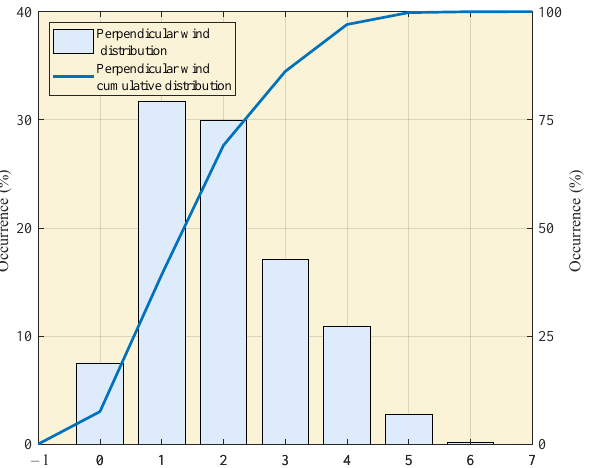
Figure 13. Distribution function and cumulative distribution function of perpendicular wind for 7 days.